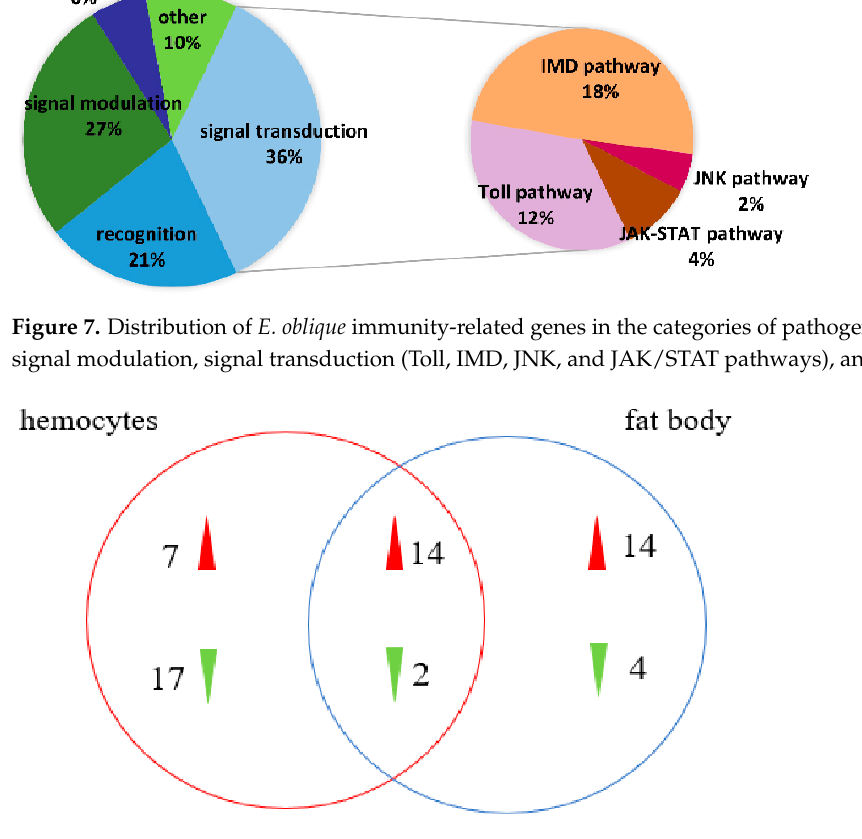
Figure 8. The immunity-related DETs in hemocytes and fat body after B. bassiana infection. In addition, we compared and analyzed some immunity-related genes of E. obliqua with those of other major insects, including members of Lepidoptera ( Bombyx mori [33], Plutella xylostella [34,35], Helicoverpa armigera [36], Lymantria dispar [19], and Hepialus xiaojinensis [37]), Coleoptera ( Tribolium castaneum [38] and Dendroctonus valens [20]), Hy- menoptera ( Apis mellifera [39]), and Diptera ( Anopheles gambiae [40] and Drosophila melano- gaster [40]). The immunity-related genes of E. obliqua (148) were similar to those of L. dispar (150). The number of immunity-related genes was highest in D. melanogaster (180) and lowest in A. mellifera (63) (Table 1) Table 1. Families and counts of innate immune genes from the insects. (The gene counts of B. mori , T. castaneum, A. mellifera , A. gambiae , D. melanogaster were based on genomic data.).